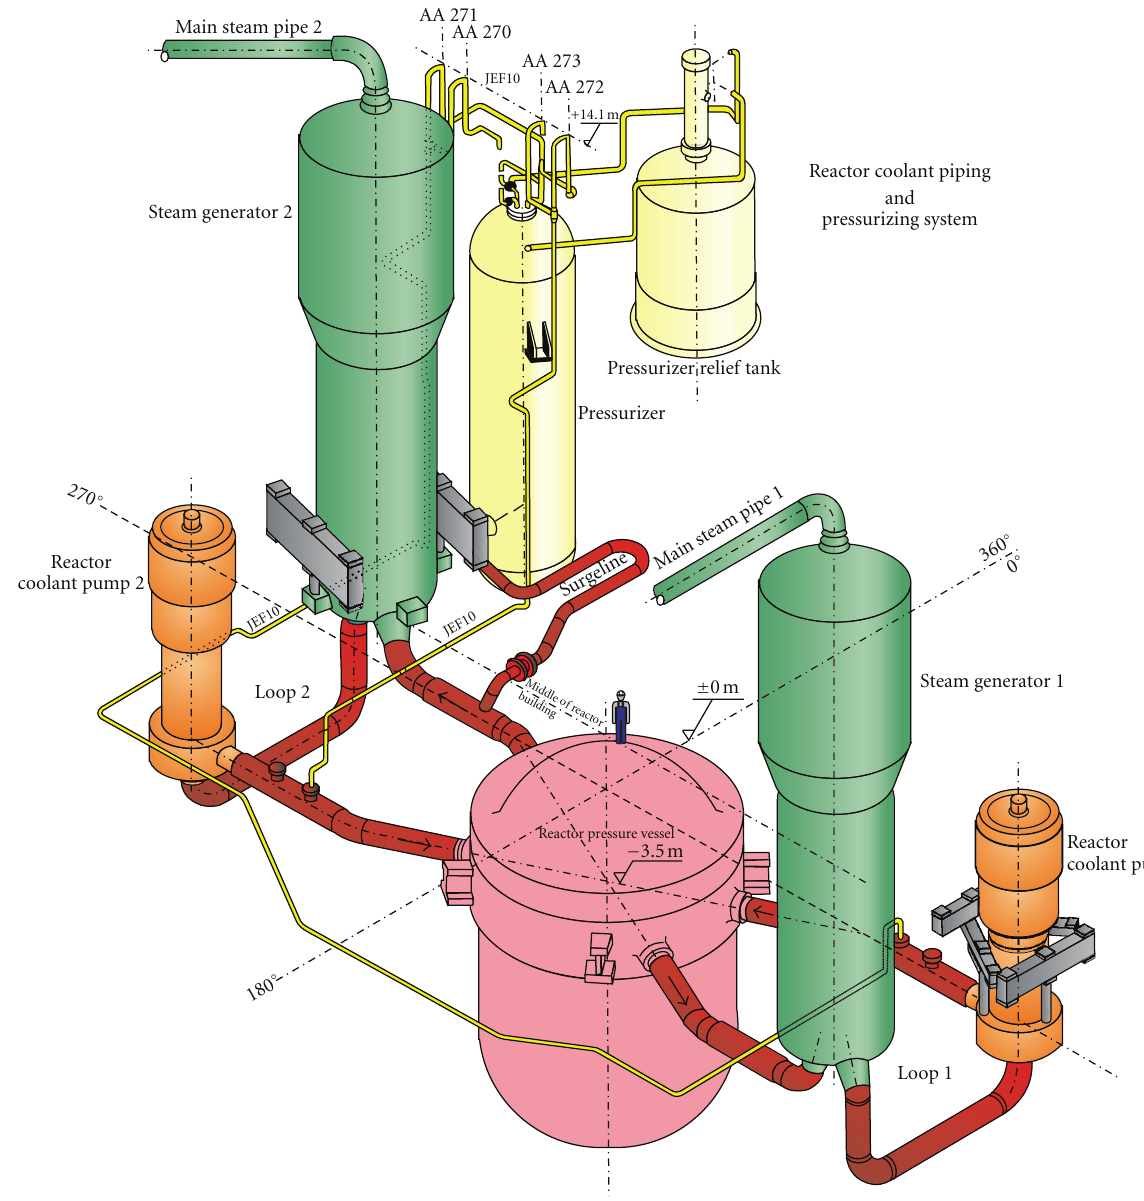
Figure 3: CNA-2 primary system